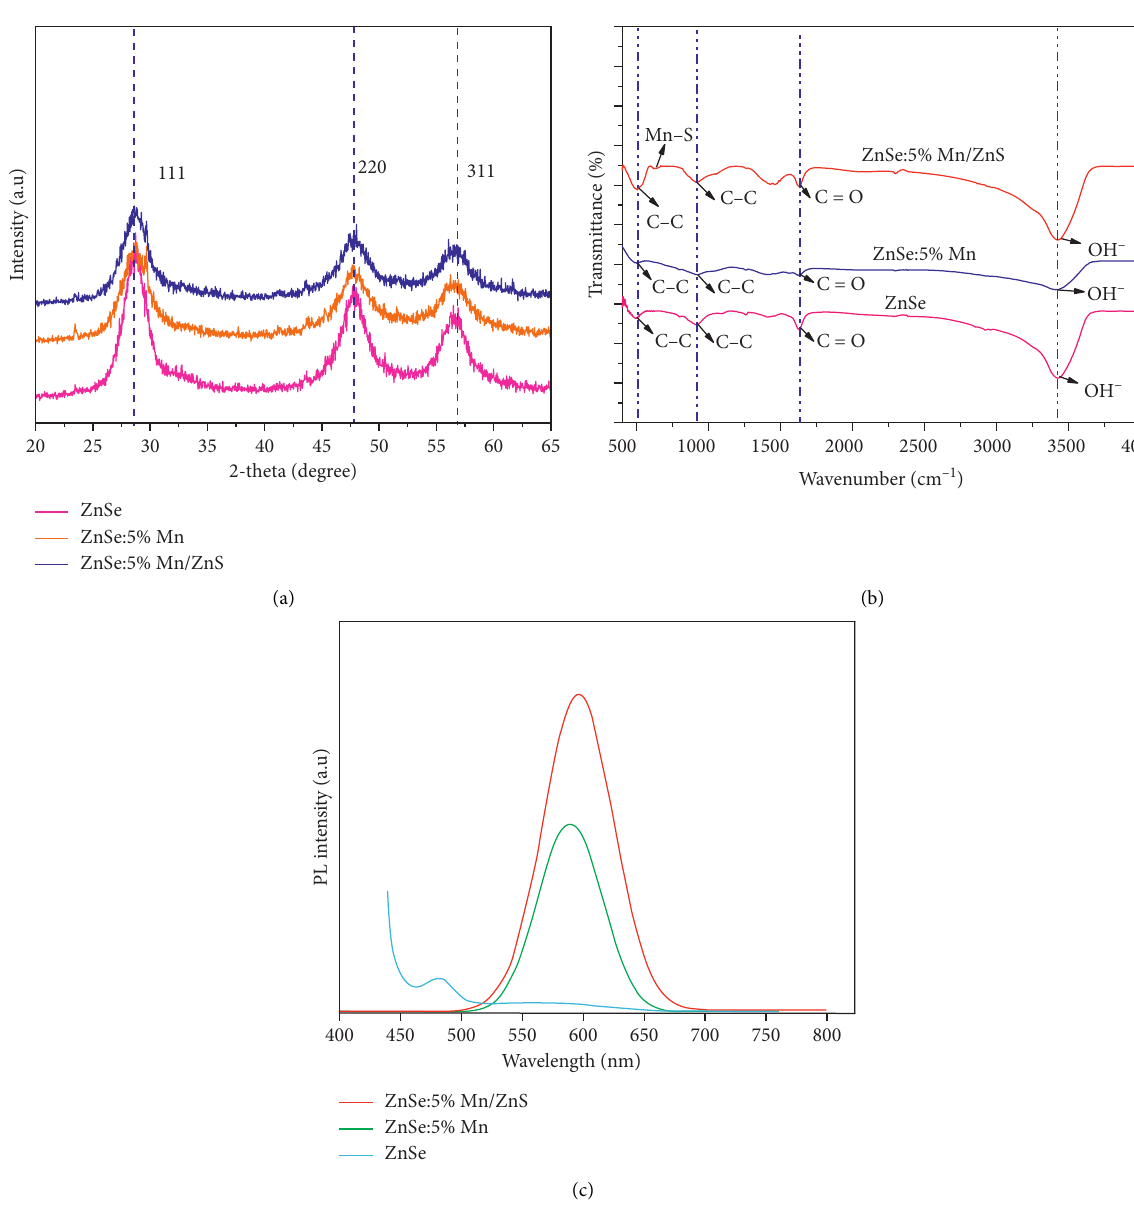
Figure 2: XRD patterns of ZnSe:Mn/ZnS with different Mn concentrations (a). FTIR spectra (b) and PL emission spectra (with 315mn excitation) of ZnSe, ZnSe:5% Mn, and ZnSe:5% Mn/ZnS